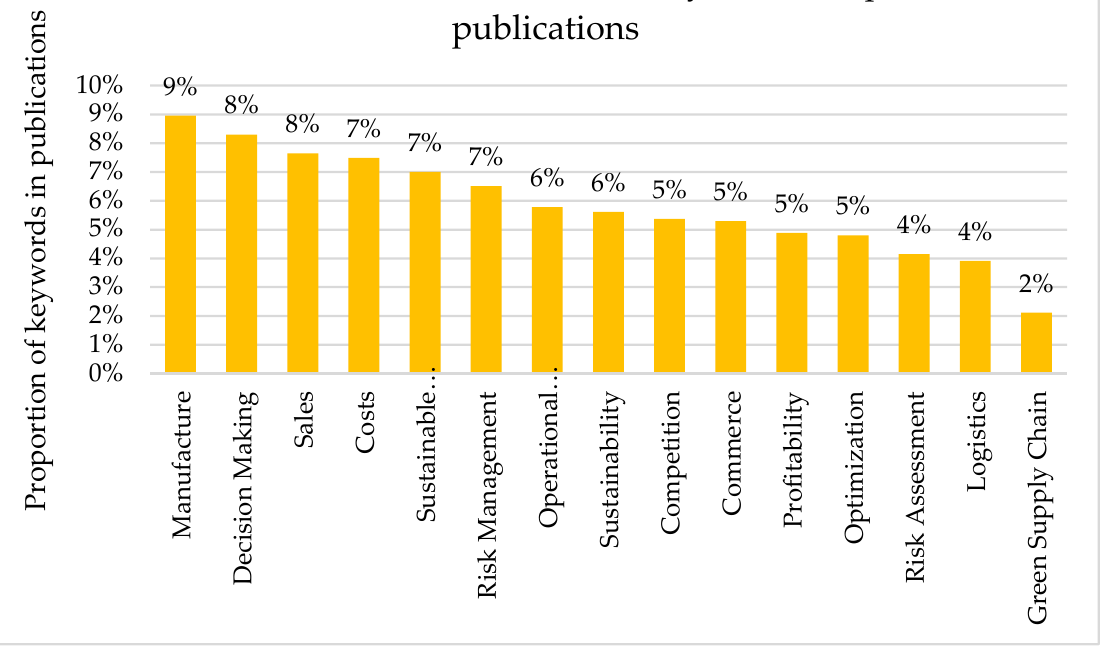
Figure 3. Distribution of keywords other than search keywords in publications (Source: Self-edit).